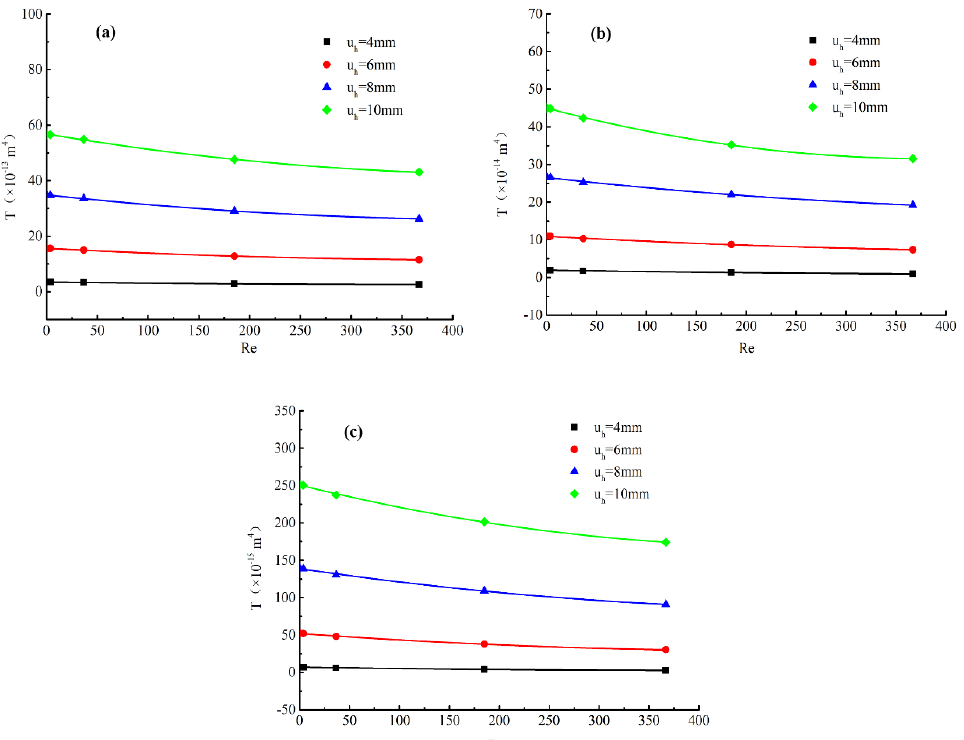
Crystals 2021 , 11 , x FOR PEER REVIEW Figure 9. Relationship between transmissivity and Reynolds number, ( a ) σ n 0 = 0.4 MPa; ( b ) σ n 0 = 0.8 MPa; ( c ) σ n 0 = 1.6 MPa.